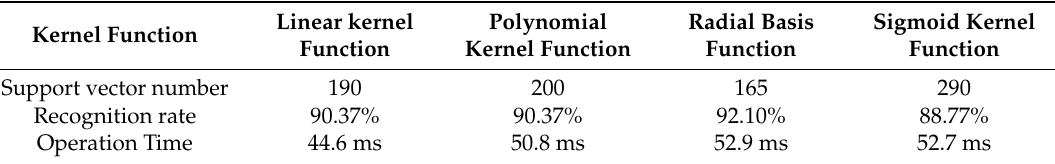
Table 2. Performance based on different kernel